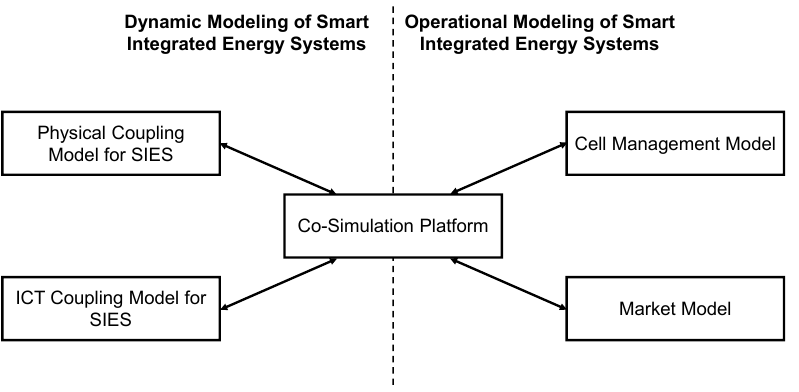
Figure 6. Simulation